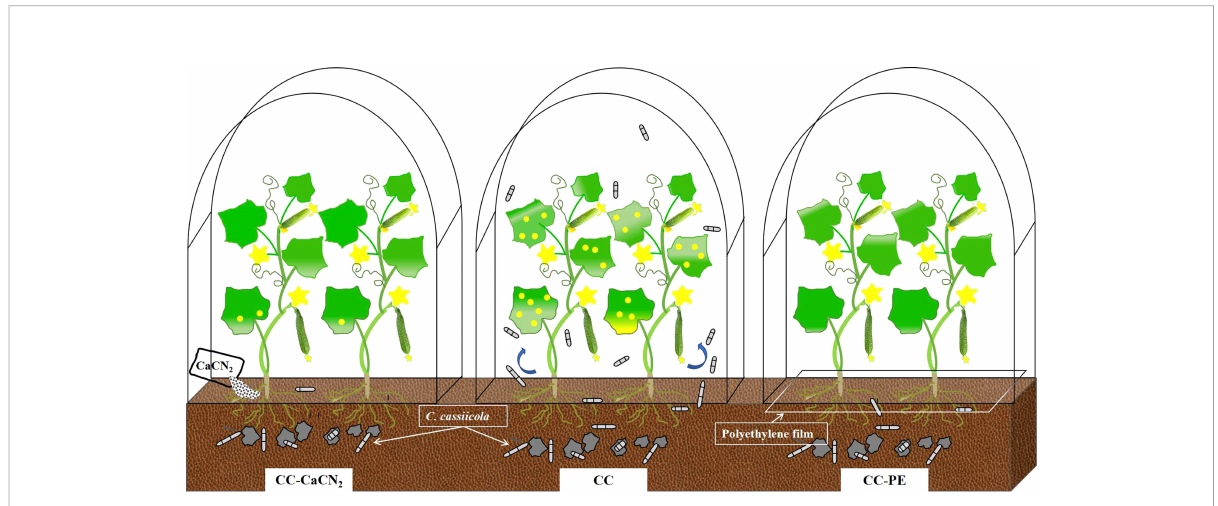
FIGURE 4 Schematic diagram of the retransmission and infection of plant leaf disease residues in